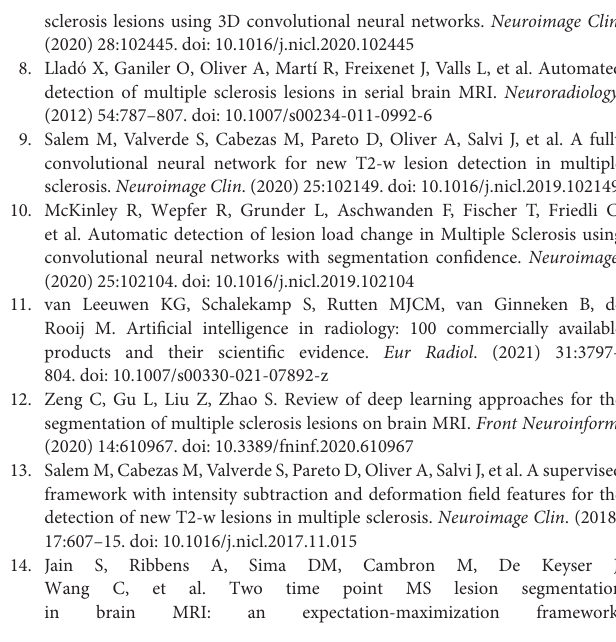
Supplementary Figure 1 | Number of patients for each new lesion count (from 0 to